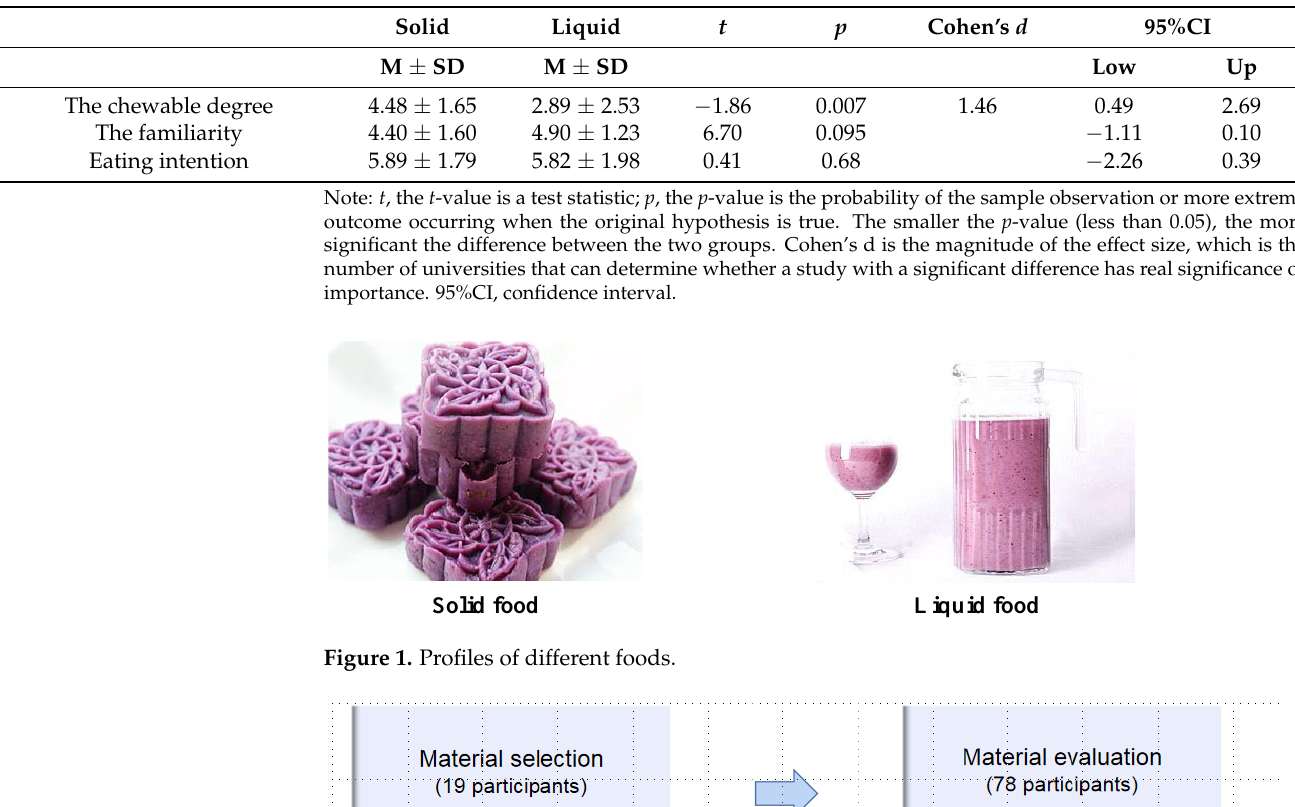
Table 1. Mean scores of different foods on chewiness degree and familiarity.